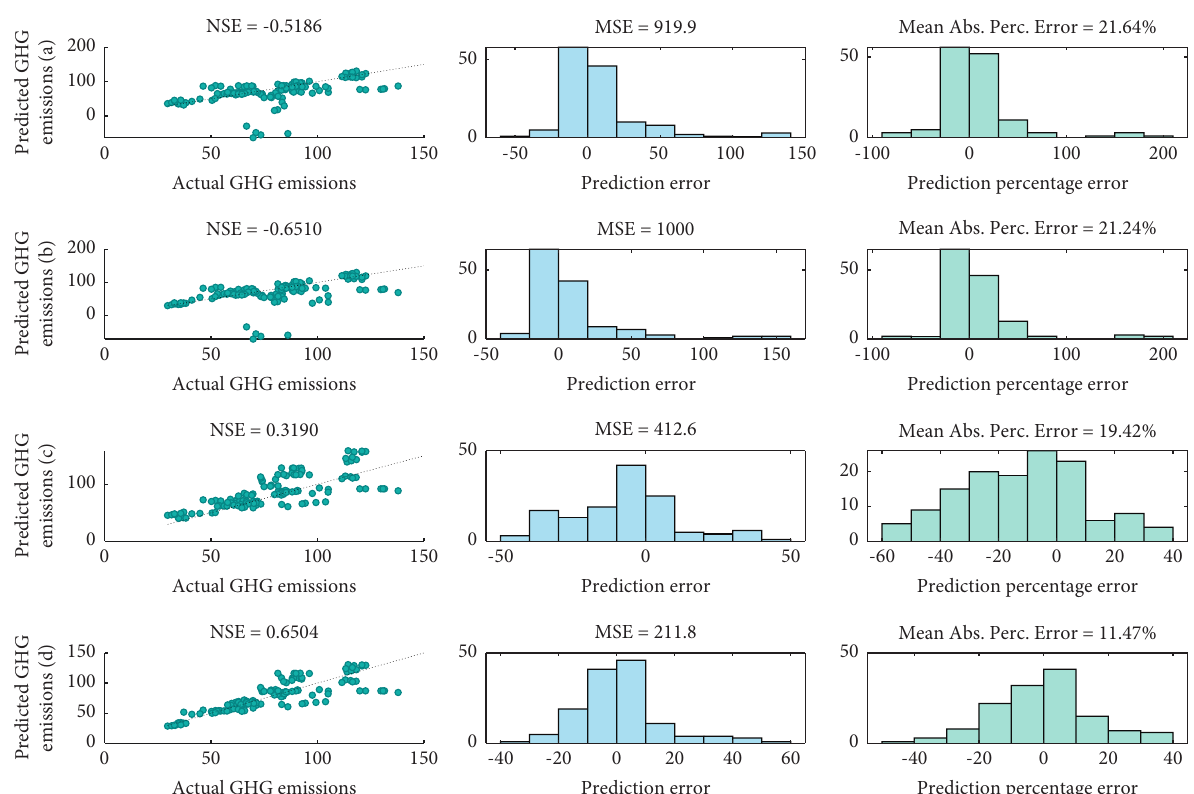
Figure 2: The comparison of predicted performance among the proposed model and the comparison models. (a) SVR, (b) RLR, (c) KGM (1, N), and (d) BKGM (1,